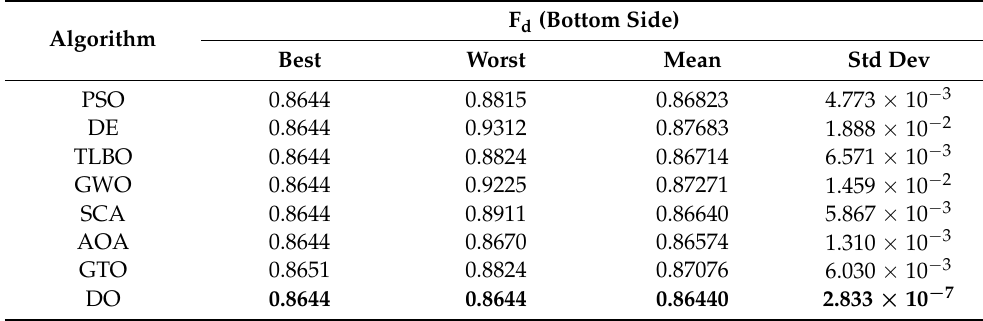
Table 5. Comparisons of nature-inspired algorithms in terms of delamination sizes at the bottom